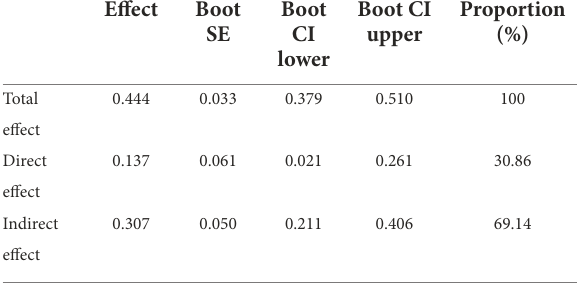
TABLE 4 The bootstrapping analysis of the mediating effects.